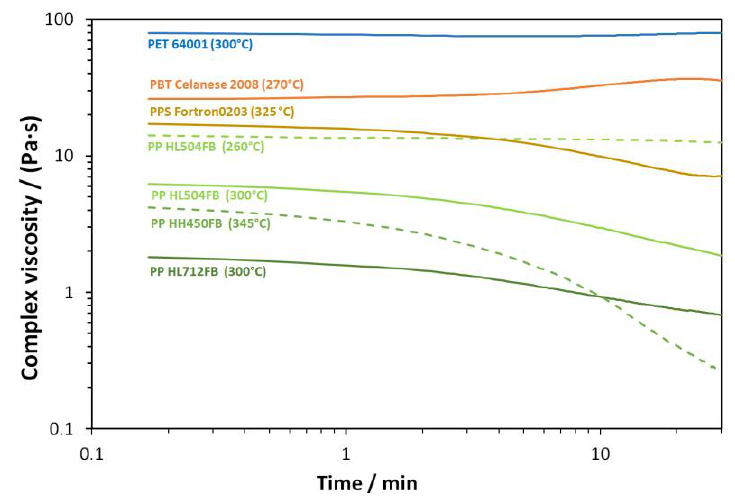
Figure A1. Time sweeps of the used polymers at relevant temperatures for processing (ε = 10%, ω = 10 rad . s −1 ) for the estimation of thermal degradation behavior under shear. As discussed in Section 3.1, the process temperature of the polyesters PBT and PET could not be raised further due to reaching critical temperature for degradation (PBT: 290 °C/PET: 330 °C). So, the temperatures used are within or close to standard process tem- peratures, and no degradation could be observed in the rheometer during the measurement (blue and orange curves in Figure A1. The viscosity drop of PPS (brown curve in Figure A1) lies in the range of the two lower viscous PP-grades (green curves in Figure A1). According to the findings from the characterized degraded nonwoven material, the high-viscous PP-type HH450FB at 345 ◦ C shows a fast drop in viscosity, which is especially accelerated after around 6 min in the rheometer.